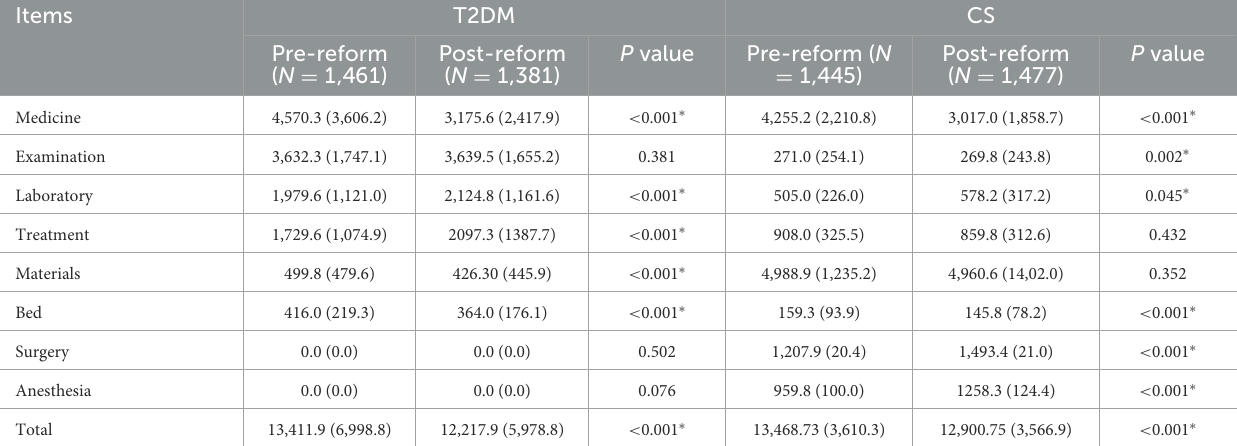
TABLE 4 Comparative analysis of the medical expenses for two diseases before and after the